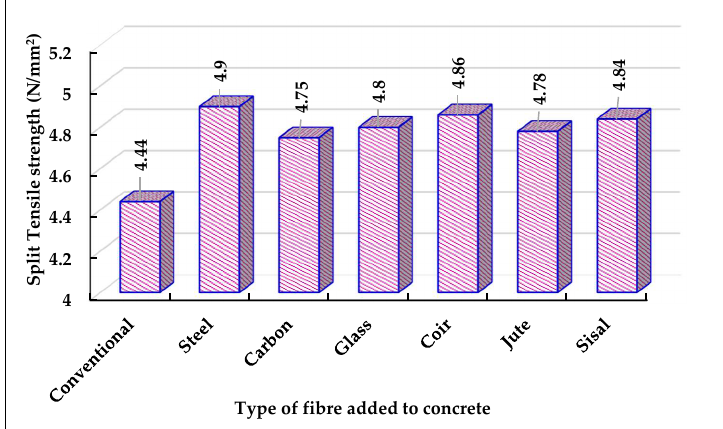
Figure 7. Graphical illustration of split tensile strength of FRC.